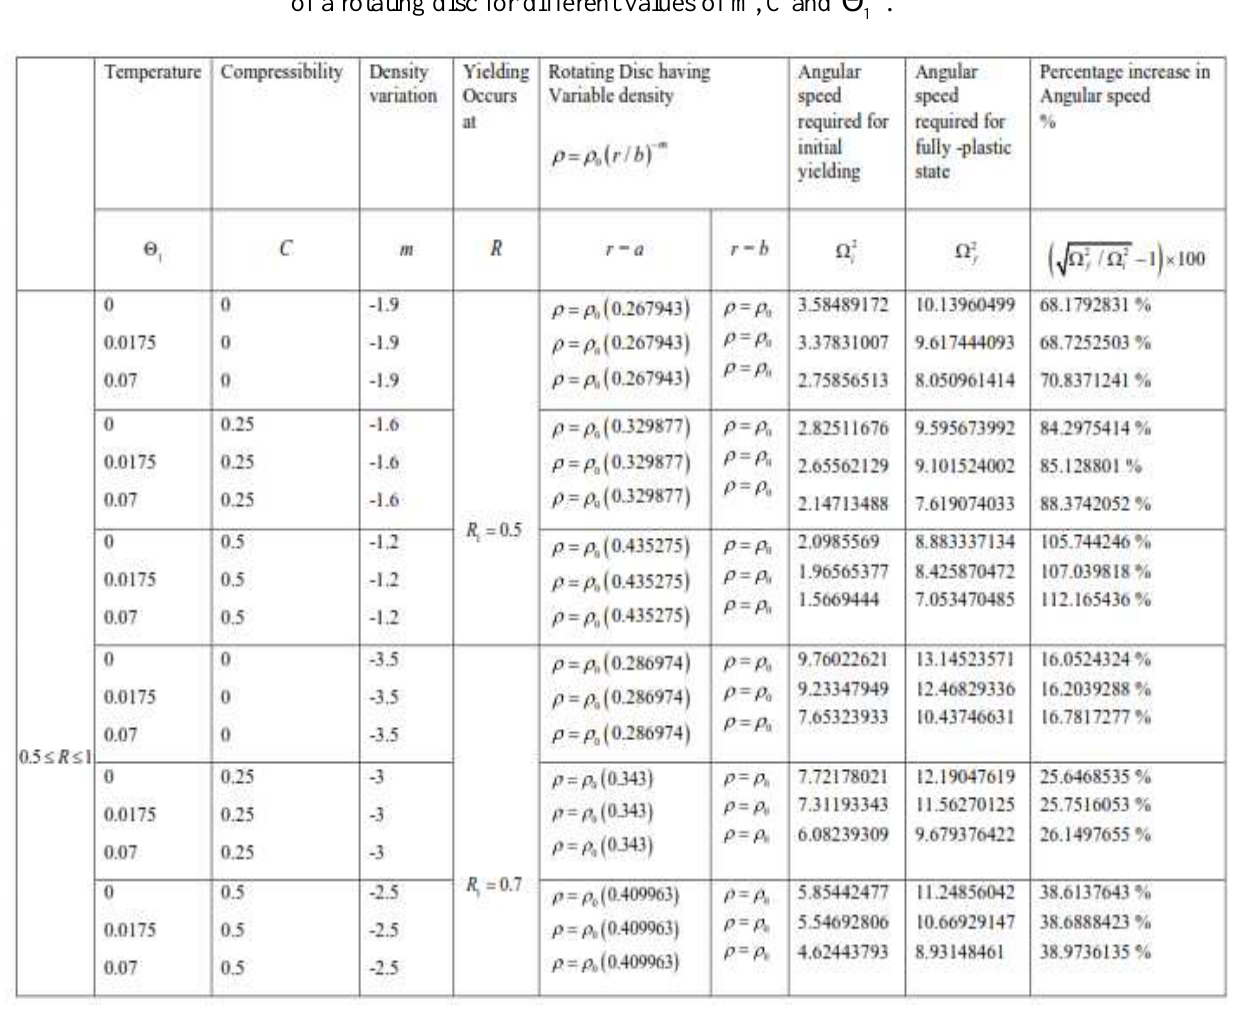
Table 1. Angular speed for initial yielding 2 of a rotating disc for different values of m, C and